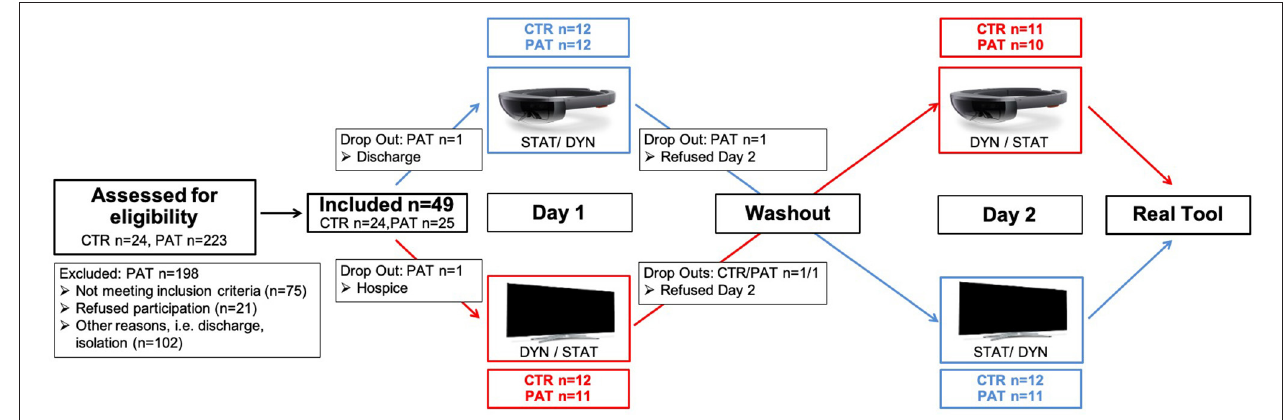
FIGURE 1 | Patients’ flow through the study. All participants had to perform the pantomime task twice (Static/Dynamic) in each Environment (HMD/Screen), followed by the real tool condition. The washout time was set to > 24h and did not include any additional tasks. Three participants only completed Day 1 and were excluded from further